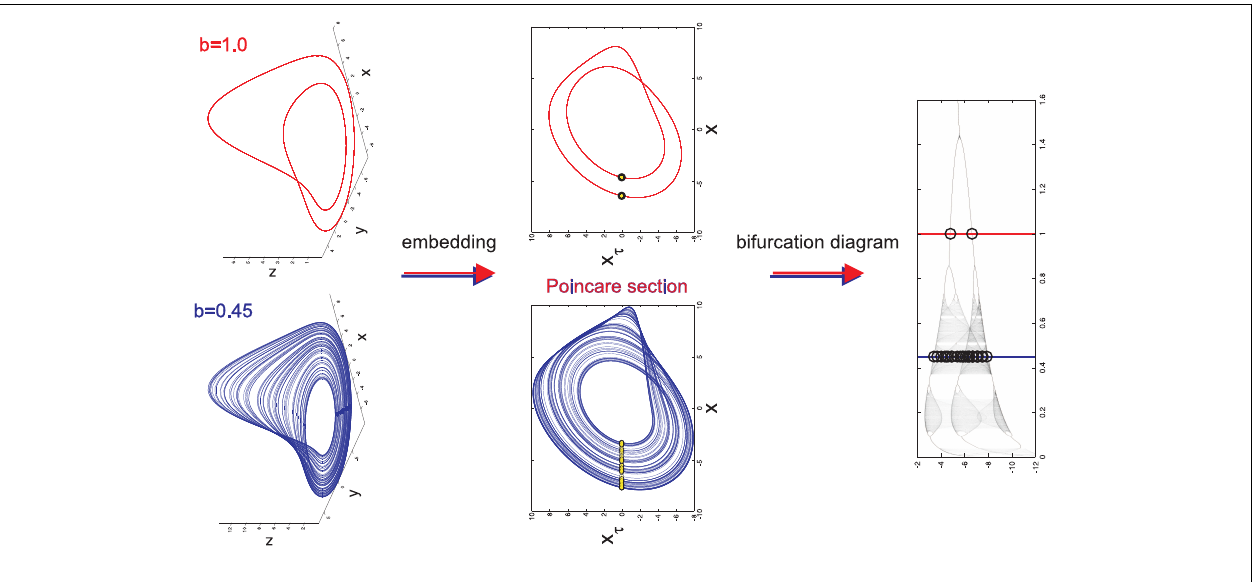
dots.The bifurcation diagram generated from the Poincaré section with b = 0.45 (blue line) and b = 1.0 (red line) marked to display the relationship between Poincaré sections and the bifurcation diagram (lower panel).